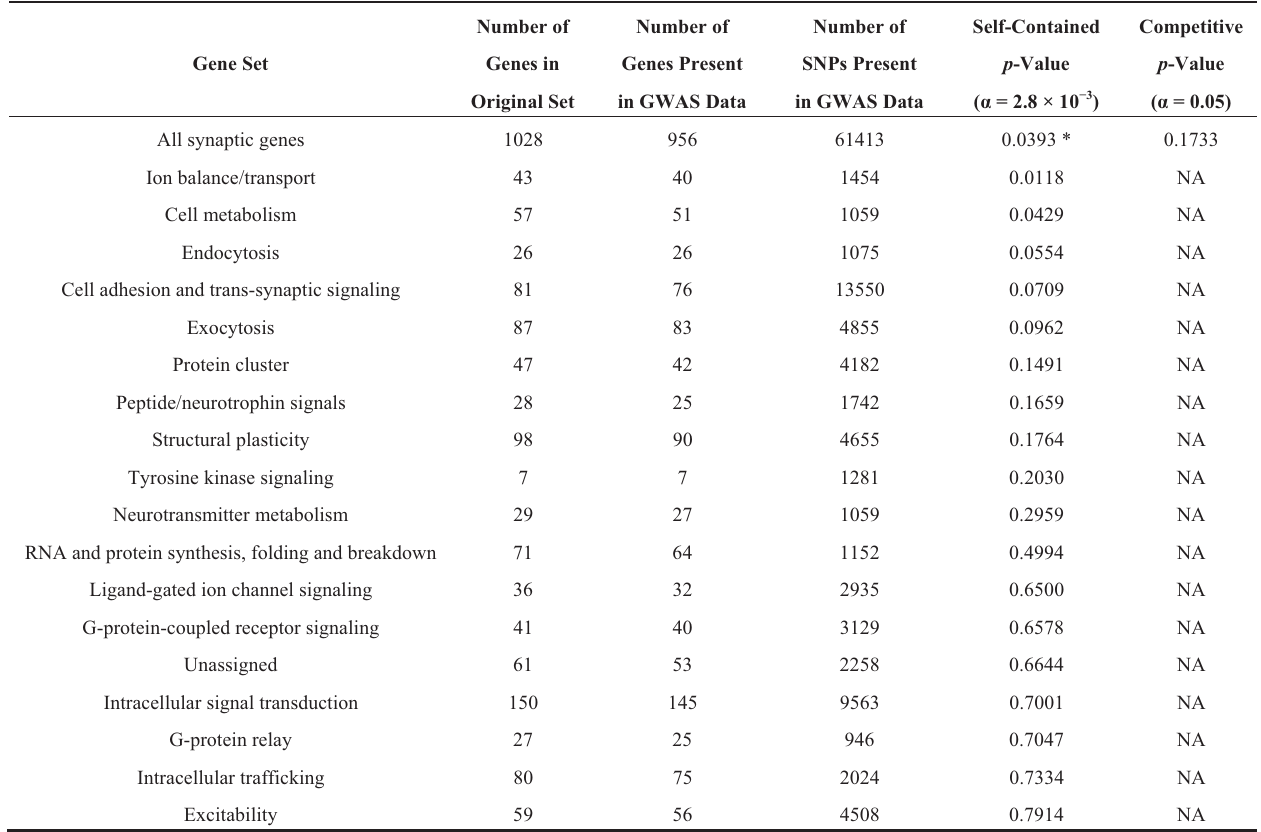
Table 1. Association findings between synaptic gene sets and